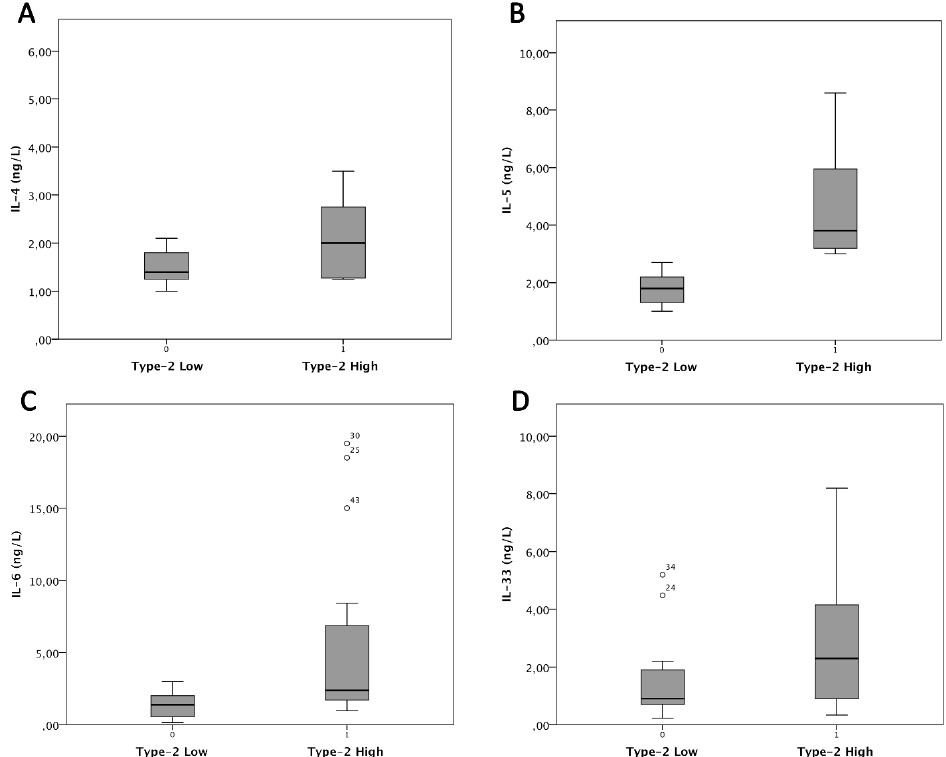
Figure 4. Cytokines’ levels based on inflammatory load. Box plots report the mean levels of the most representative cytokines according to the load of type 2 inflammation (high and low). Differences in mean levels of IL ‐ 4 (panel A ), IL ‐ 5 (panel B ), and IL ‐ 6 (panel C ) were significant between the two subgroups, while IL ‐ 33 (panel D ) showed a non ‐ significant difference. In ROC analyses, IL ‐ 5 was the best biomarker that could identify the two clusters among the cytokines detected in nasal secretions. In Figure 5, the ROC curves for IL ‐ 5, IL ‐ 4 IL ‐ 6 and IL ‐ 33 are shown. Specific ROC analyses for IL ‐ 5 levels in nasal secretions re ‐ vealed that the area under the curve (AUC) was 0.866 (95% CI 5 0.761–0.970), a sensitivity of 70%, and a specificity of 93.3% were obtained for a cut ‐ off of IL ‐ 5 superior to 2.3 ng/l. Finally, a significant difference in local eosinophilia was observed between group 1 and group 2 with a mean eosinophil count per high power field (Ec ‐ hpf) of 27.8 ± 6.1 and 4.7 ± 2.5 ( p < 0.05), respectively. In ROC analyses, we observed that the AUC was 0.966 (95% CI 5 0.957–1.000) and an eosinophil count >15.5 Ec ‐ hpf was highly predictive for the type 2 ‐ high cluster.